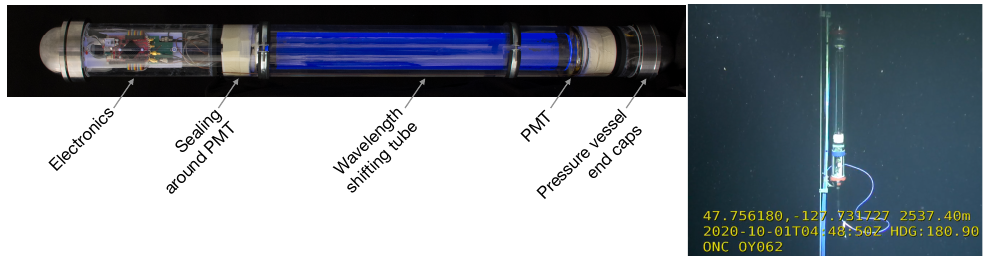
Figure 16. A demonstrator device made in the prototype configuration and photographed under UV illumination ( left ). The electronics comprise a PMT pulse readout, environmental sensors, and communication. After deployment, a photograph was taken by a robot in the Ocean Network Canada. ( right ). Right picture: Courtesy of the